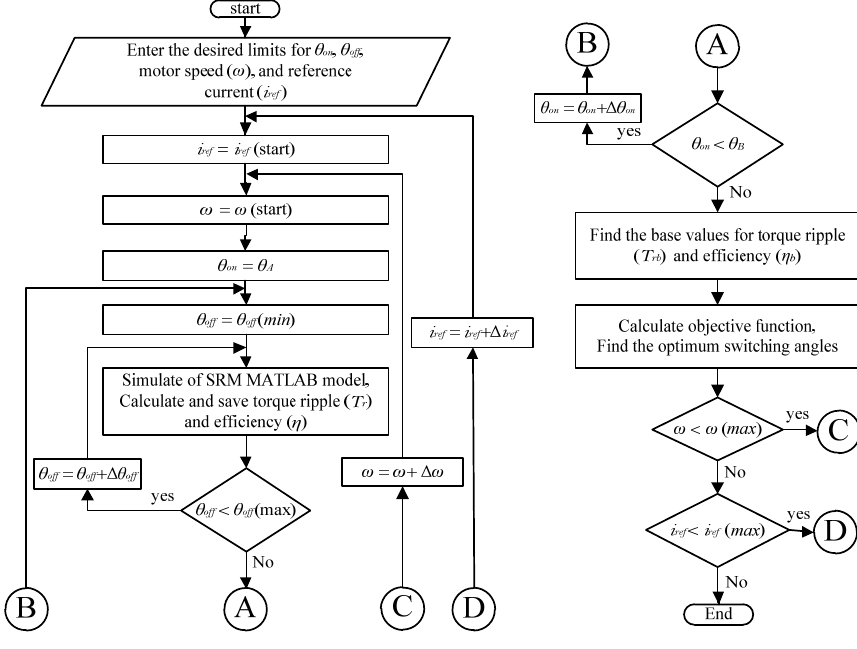
Figure 6. The flowchart of the searching algorithm.